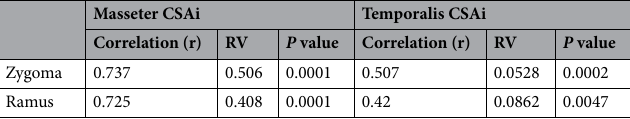
Table 1. Integration between facial skeleton and masticatory muscle CSAi.